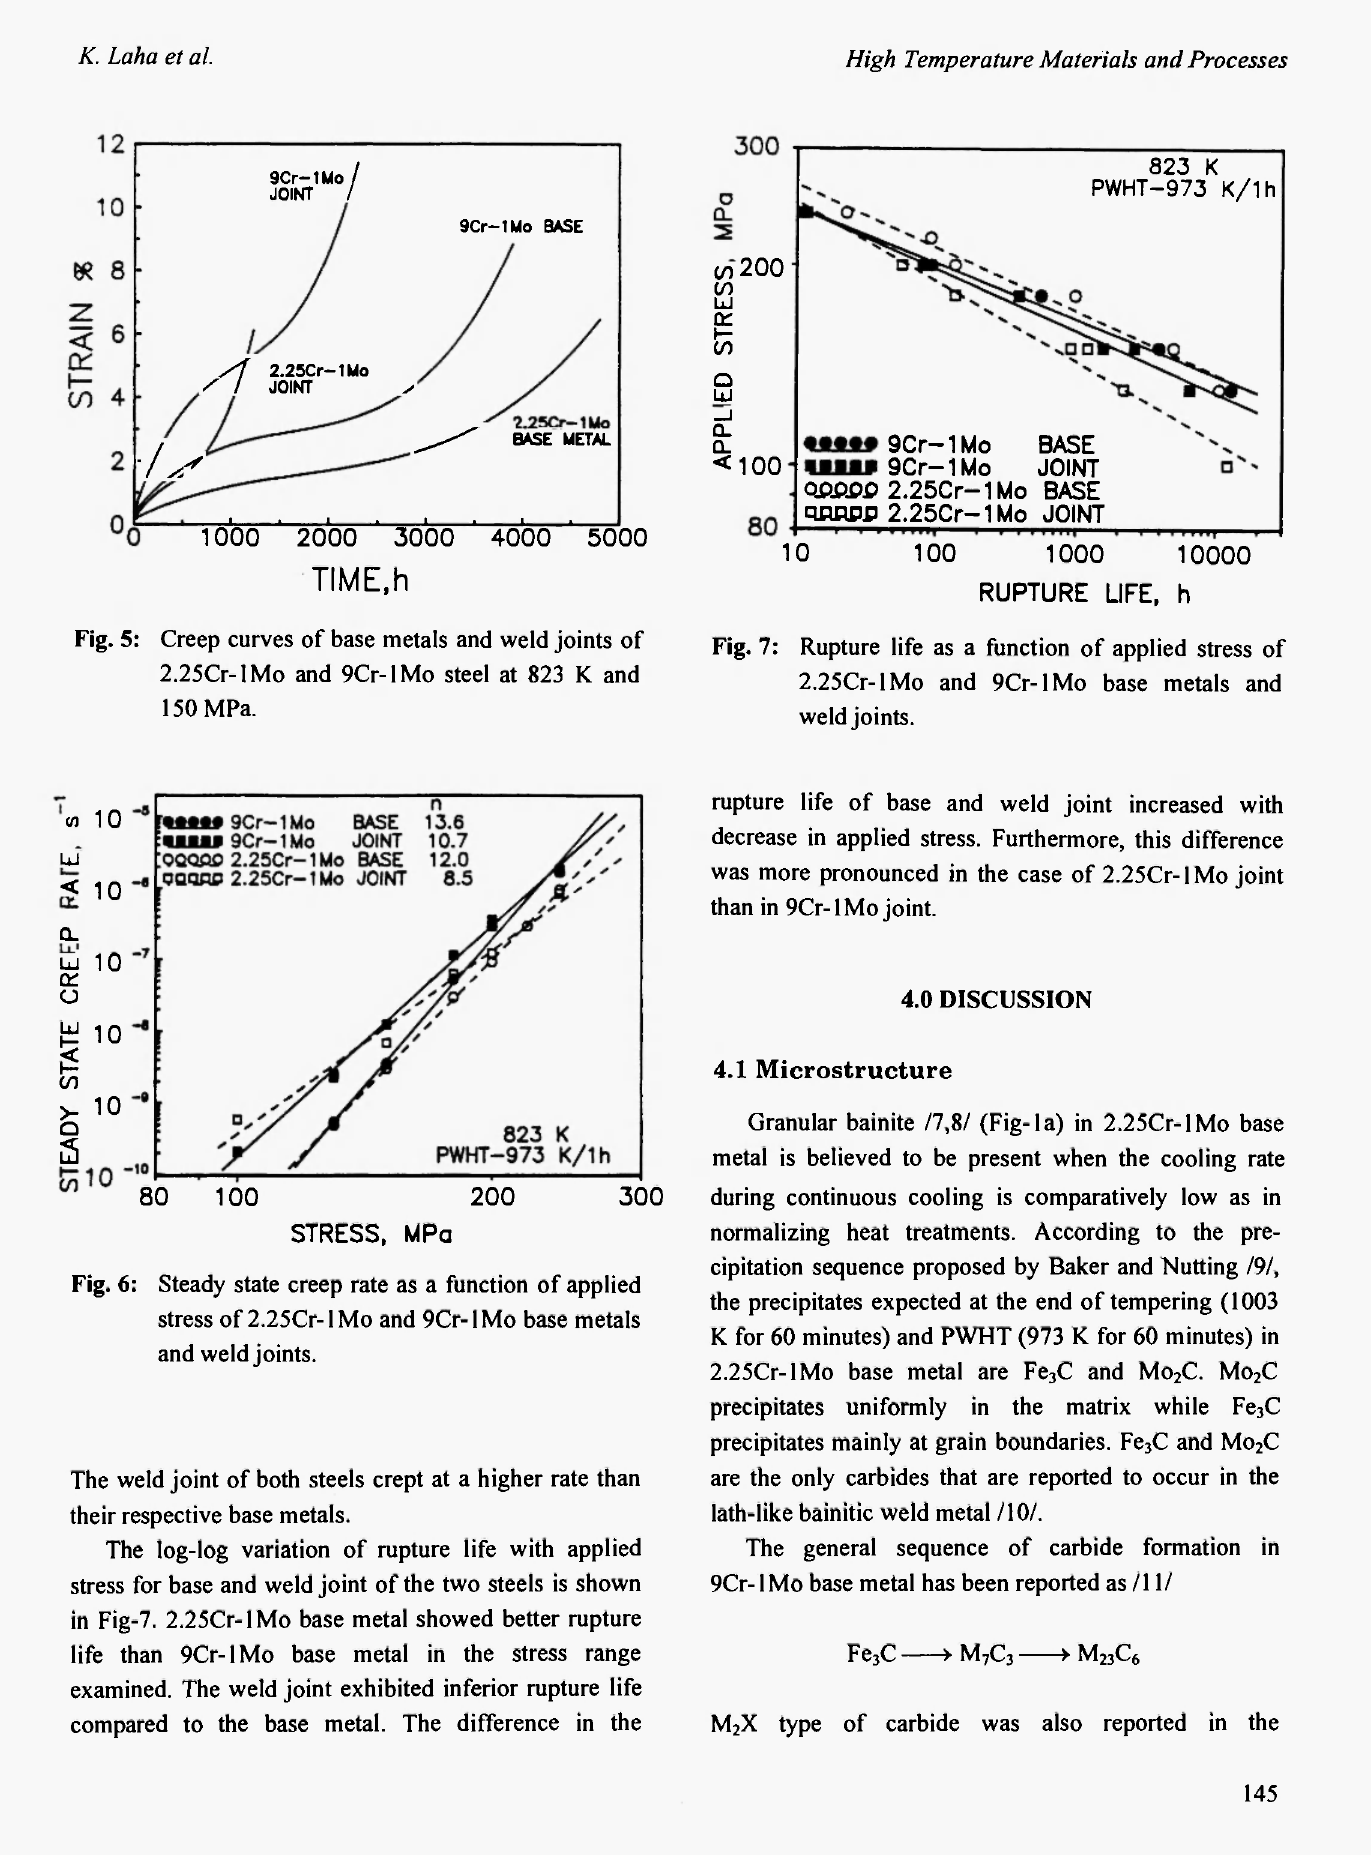
Fig. 6: Steady state creep rate as a function of applied stress of 2.25Cr-lMo and 9Cr-lMo base metals and weld